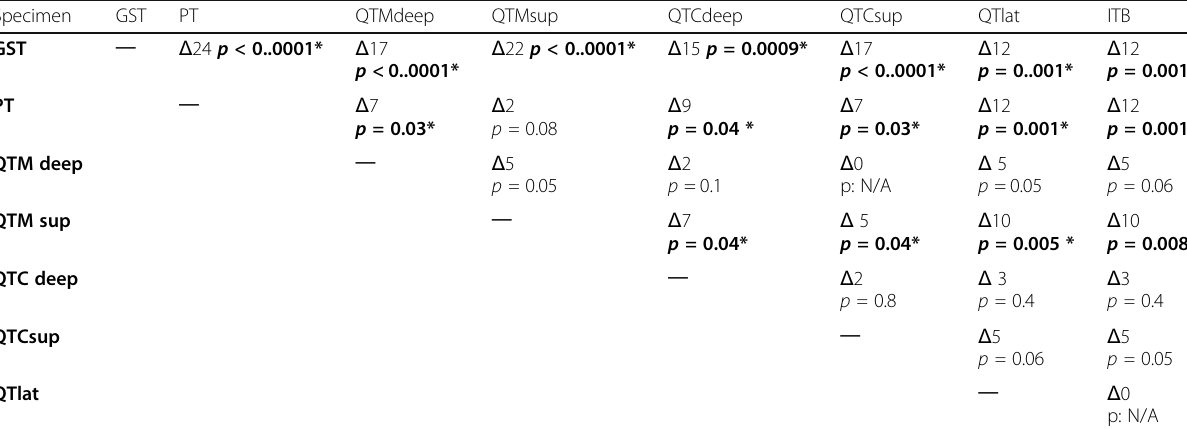
Table 5 Comparison between specimens in terms of Ultimate Deformation (Mean values) Specimen GST PT QTMdeep